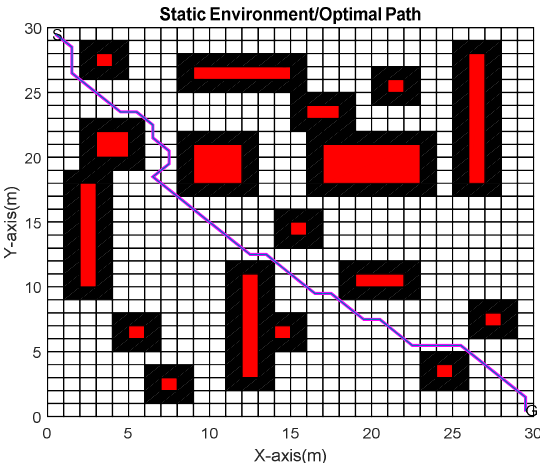
Fig. 14. Best Path found by Standard ACO for Experiment 3